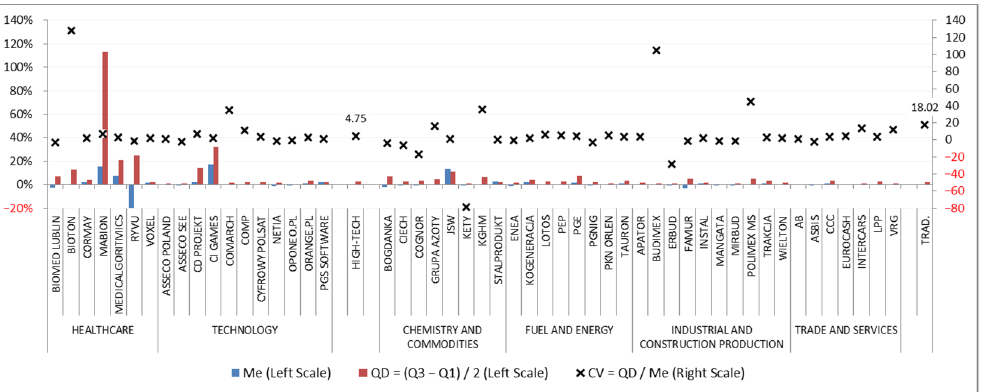
Figure 8. Assessment of changes in the operating cost level ratio in the surveyed enterprises. Source: own work.